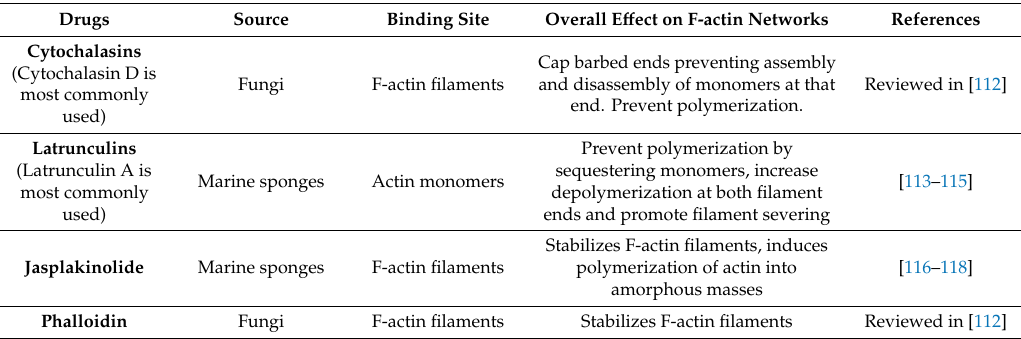
Table 1. Summary of the main properties of actin-targeting drugs and their e ff ects on F-Actin networks. Drugs Source Binding